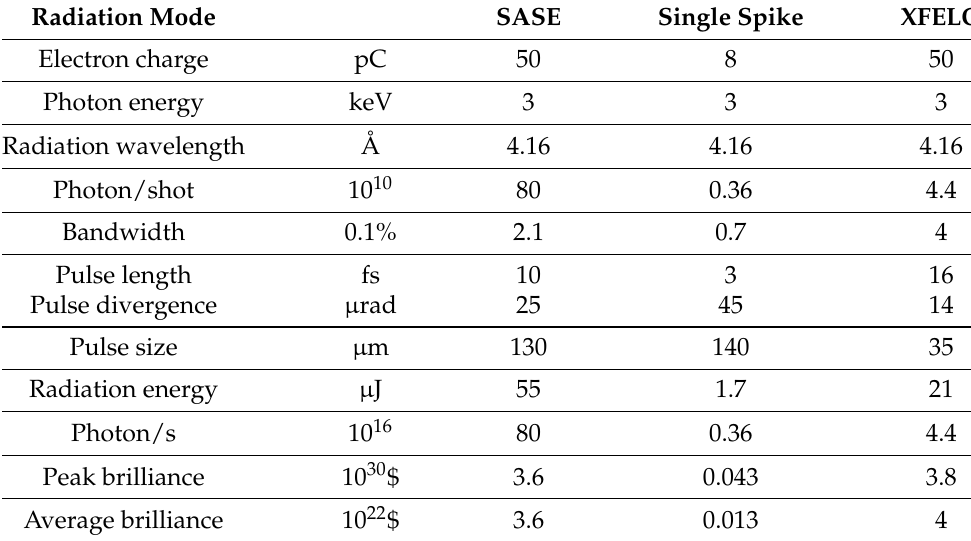
Figure 6. Intracavity power vs. s and spectrum vs. λ as a function of the round trip number in logarithmic scale. XFELO ( a ) intra-cavity power vs s = c τ and ( b ) spectrum vs λ as function of the round trip number. Logarithmic scale. Table 2. The repetition rate of the source is 1 MHz. $=Photons/s/mm 2 /mrad 2